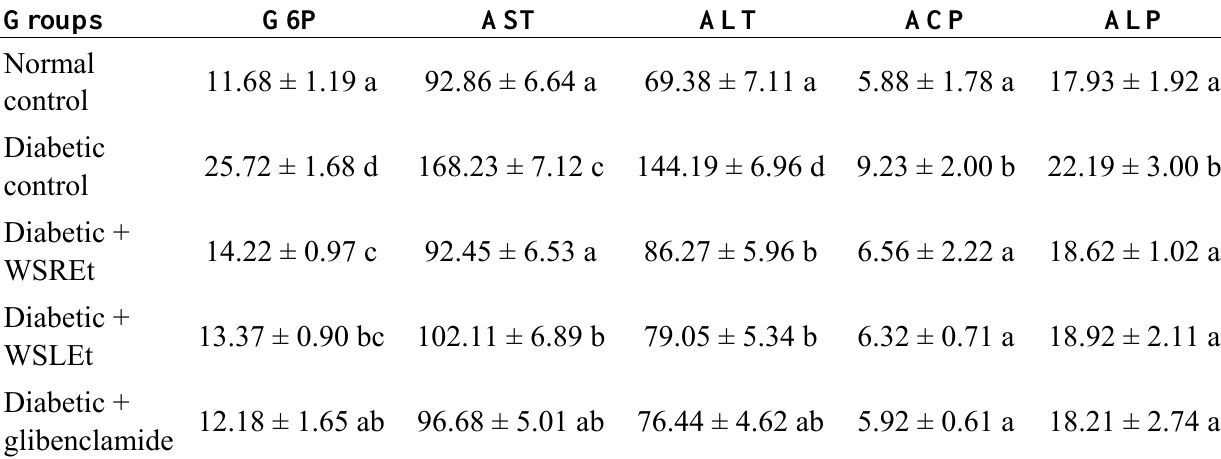
Table 8. Effects of W. somnifera (L.) extracts on liver G6P and serum enzymes AST, ALT, ACP and